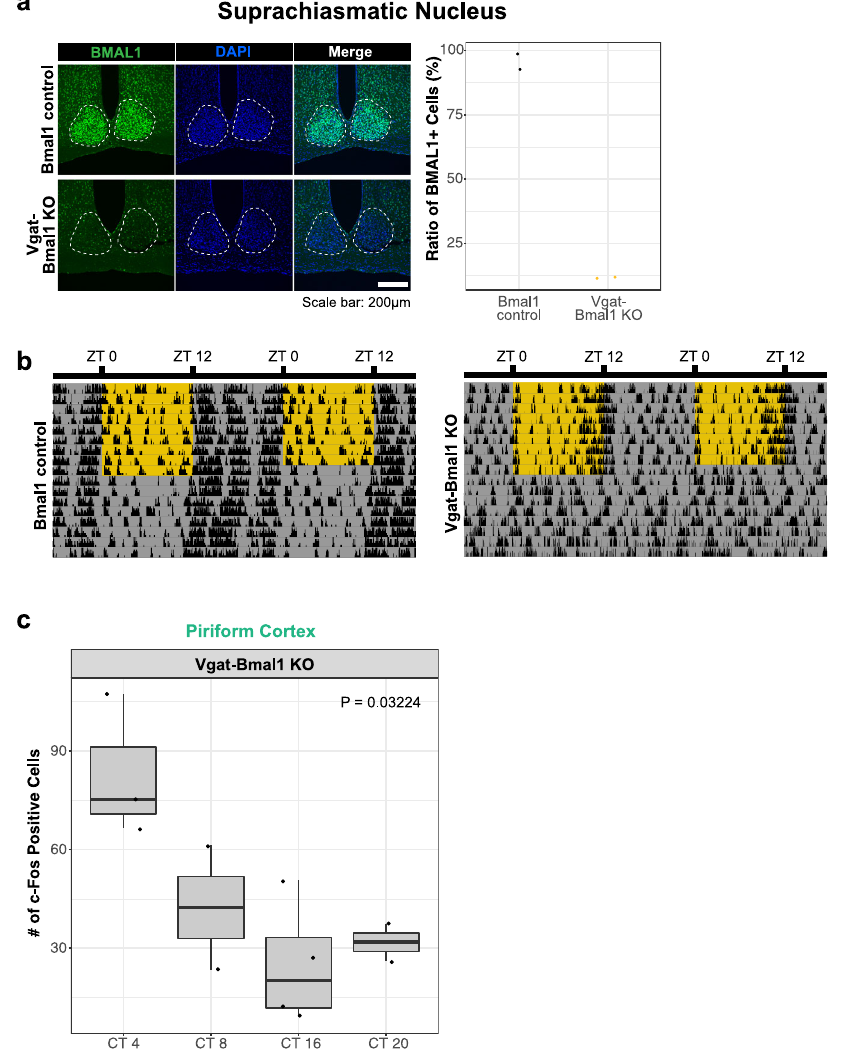
Fig. 2 Bmal1 KO in the SCN fails to in fl uence the circadian rhythmicity of the odor-evoked neural activity in the PC. a Representative images of the suprachiasmatic nucleus (SCN) of Bmal1-control mice and Vgat-Bmal1 KO mice, immunohistochemically stained with BMAL1 antibody. The ratios of BMAL1 + cells over DAPI + cells were quanti fi ed in the SCN. b Representative locomotor activity patterns of Bmal1-control mice and Vgat-Bmal1 KO mice. Yellow shades and gray shades indicate light ON and OFF respectively. c Quanti fi cation of c-Fos positive cells in the PC of Vgat-Bmal1 KO mice which underwent odorant exposure identical to Fig. 5A. N = 3, 2, 4, 2 for CT4, CT8, CT16, CT20, respectively. p = 0.03224, one-way ANOVA. The line at the center of each boxplot depicts the median; the box depicts the third quartile and fi rst